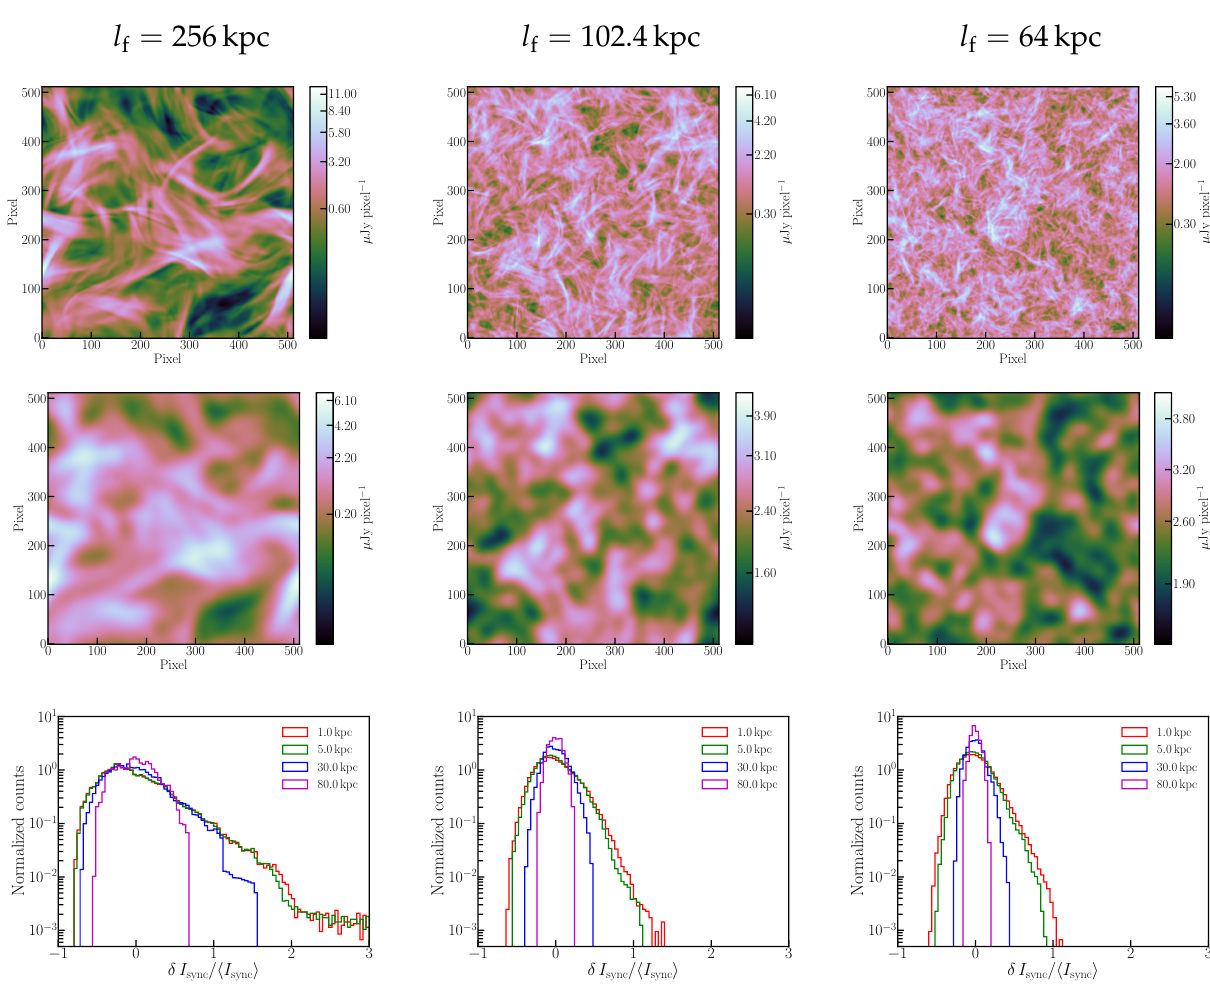
Figure 3. ( Top row ): The 2-D maps of surface brightness of the total synchrotron emission ( I sync ) at the native 1kpc resolution of the simulations. ( Middle row ): Synchrotron total intensity maps in the top row smoothed by a Gaussian kernel with FWHM = 30kpc. ( Bottom row ): Pixel-wise distribution of δ I sync / on different scales shown with different colours. The ( Left ), ( middle ) and ( right ) columns are for synthetic observations of l f = 256kpc at t / t ed = 23, l f = 102.4kpc at t / t ed = 20.2, and l f = 64kpc at t / t ed = 30.6,